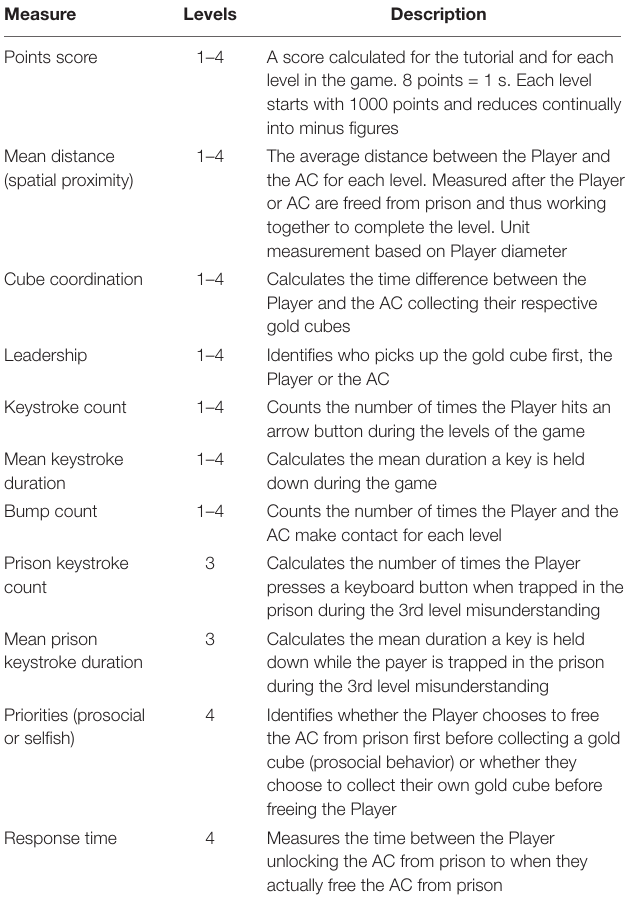
TABLE 1 | List of behavioral measures from the Dyad3D